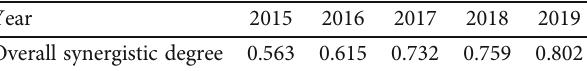
Table 9: Overall synergistic degree of the CME management synergy system in Henan